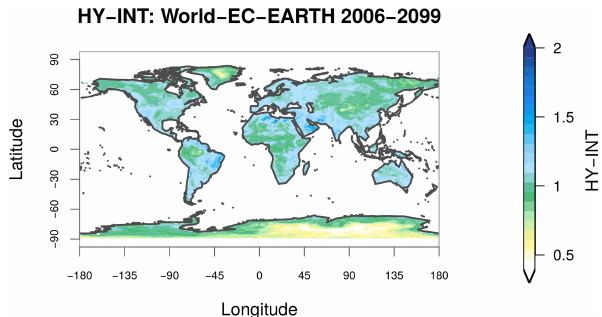
Figure 1. Mean hydroclimatic intensity index (i.e. a combination of precipitation intensity and dry spell length normalized com- pared to a reference period) over the years 2006–2099, for the EC-EARTH model RCP8.5 projection. The historical years 1976– 2005 were used as the reference period. The figure is an example of a large number of different plots which can be produced with recipe_hyint.yml , similar to (Giorgi et al., 2014). For details see Sect.